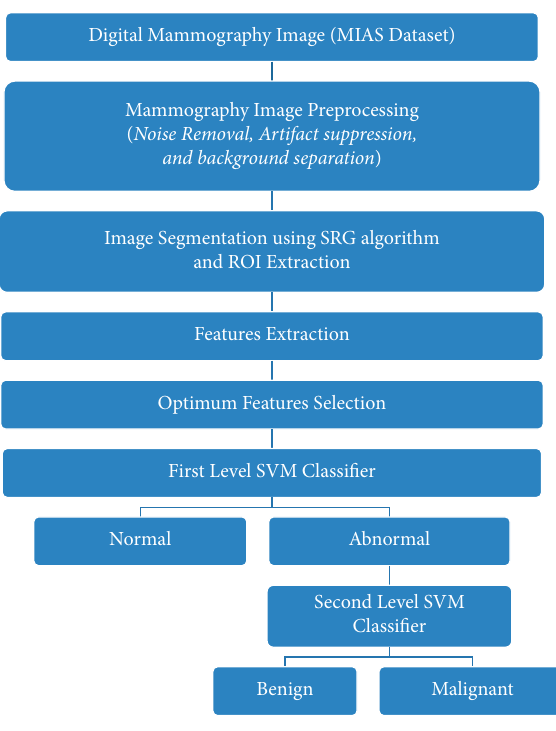
Figure 1: A flow diagram of the proposed CAD system